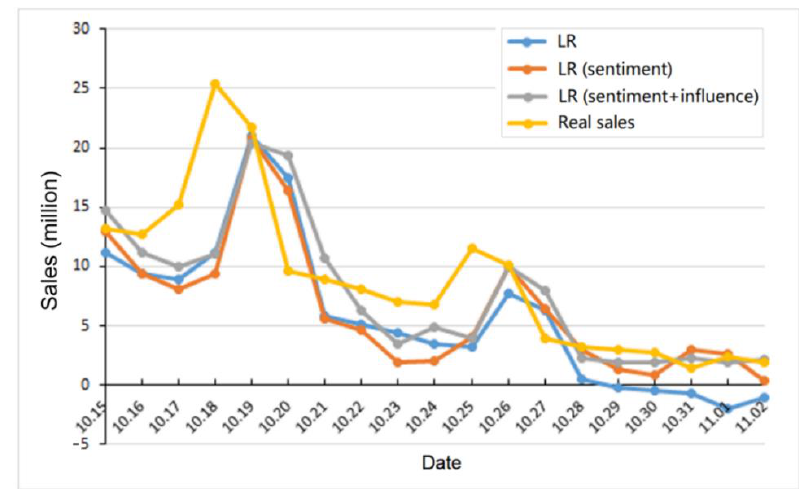
Figure 2. Prediction results of the LR model with different features.